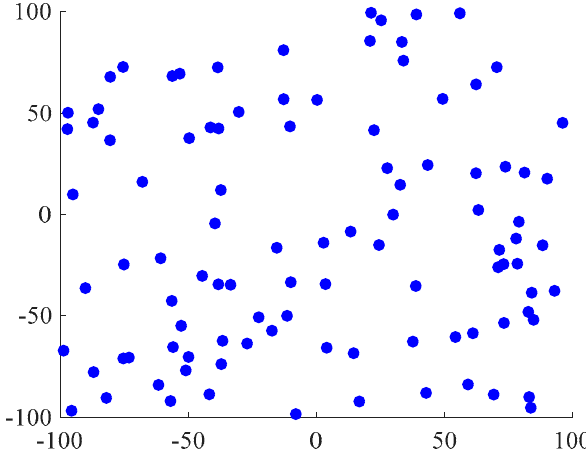
Figure 1. Random initial population.